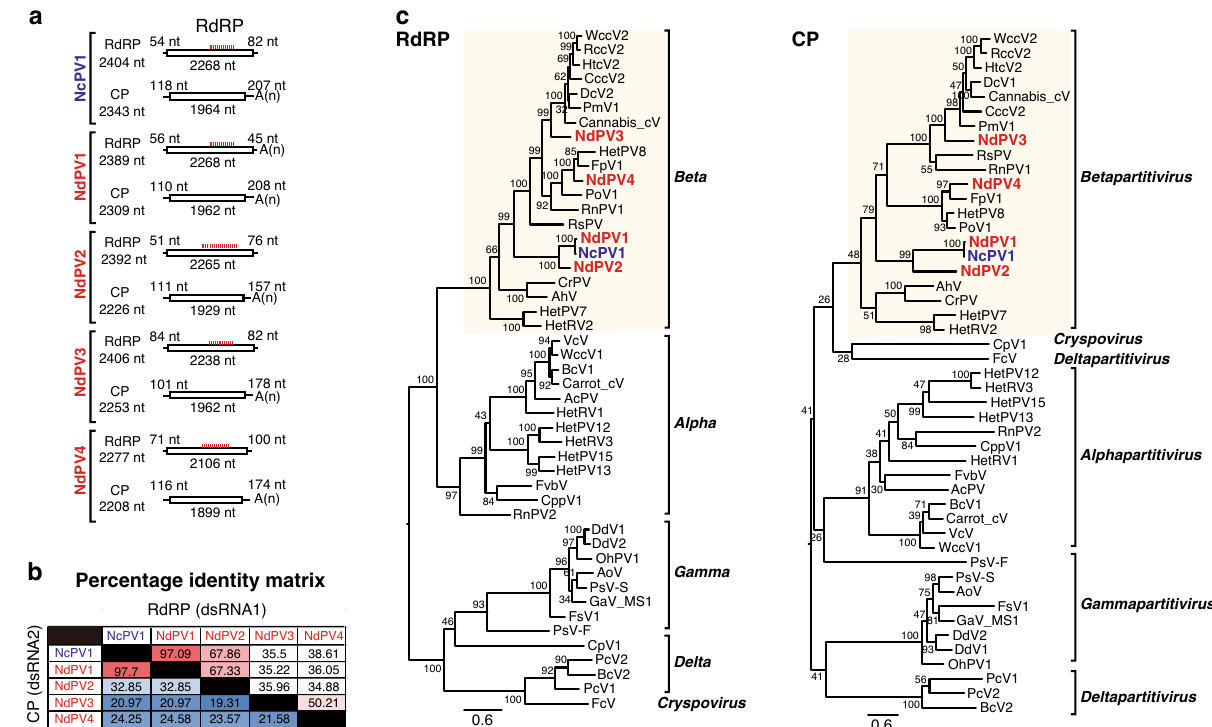
Fig. 3 Sequence and phylogenetic analyses of partitiviruses detected from the strains of Neurospora species. a Genome structure of Neurospora crassa partitivirus 1 (NcPV1), and Neurospora discreta partitivirus 1 – 4 (NdPV1 – 4). The clear boxes indicate open-reading frames (ORFs) with their lengths shown below. The lengths of the 5 ′ - and 3 ′ -untranslated regions, and intergenic regions are indicated in nucleotides. b Percent identity matrix (PMI) among partitiviruses detected from two Neurospora species, N. crassa, and N. discreta . See Fig. 1b legend for detailed explanation. c The maximum-likelihood (ML) phylogenetic trees based on alignment of the entire region of RdRP and CP using RAxML-NG. See Fig. 1c legend for methodology. Virus abbreviations are summarized in Supplementary Table